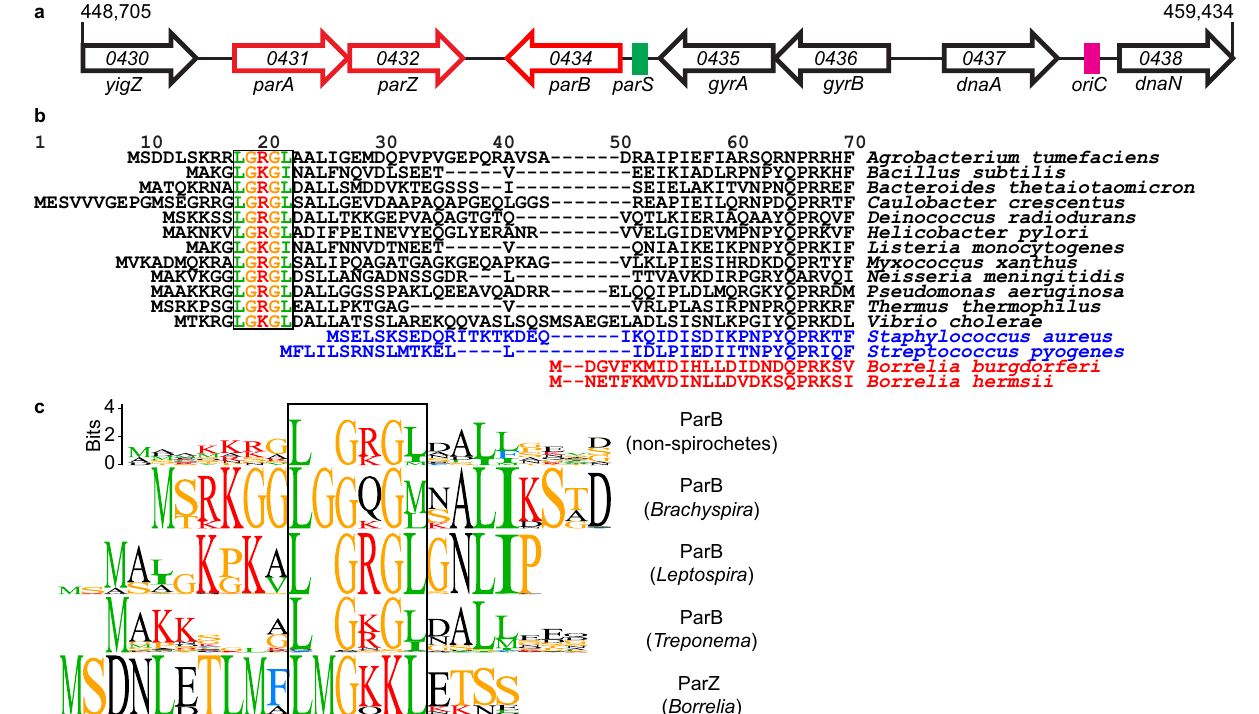
Fig. 5 | B. burgdorferi ParB lacks the N-terminal peptide that controls ParA localization. a Schematic of the oriC -proximal chromosome region of B. burg- dorferi strain B31, between nucleotides 448,705 and 459,434, showing the par genes. Features are not drawn to scale. We propose renaming the gene bb0432 of hypothetical function to parZ . b Alignment of chromosomally encoded ParB sequences from the indicated species. The fi rst 70 positions of the alignment are shown here, while the full alignment is displayed in Supplementary Fig. 5a. High- lighted is the conserved LG(R/K)GL motif of ParB ’ s N-terminal ParA ATPase-